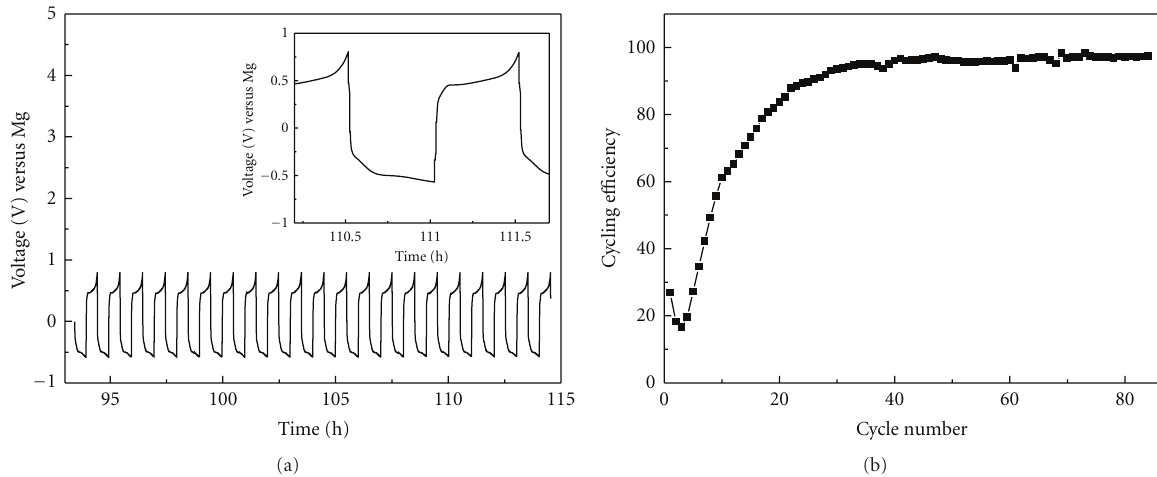
Figure 8: Typical galvanostatic cycling curves (a) Inset shows one of the cycle curves, and cycling e ffi ciencies (b) for Mg deposition- dissolution on Cu substrate in 0.3mol L − 1 Mg(CF 3 SO 3 ) 2 /BMImBF 4 + THF (3:1). The counter electrode is Mg sheet.